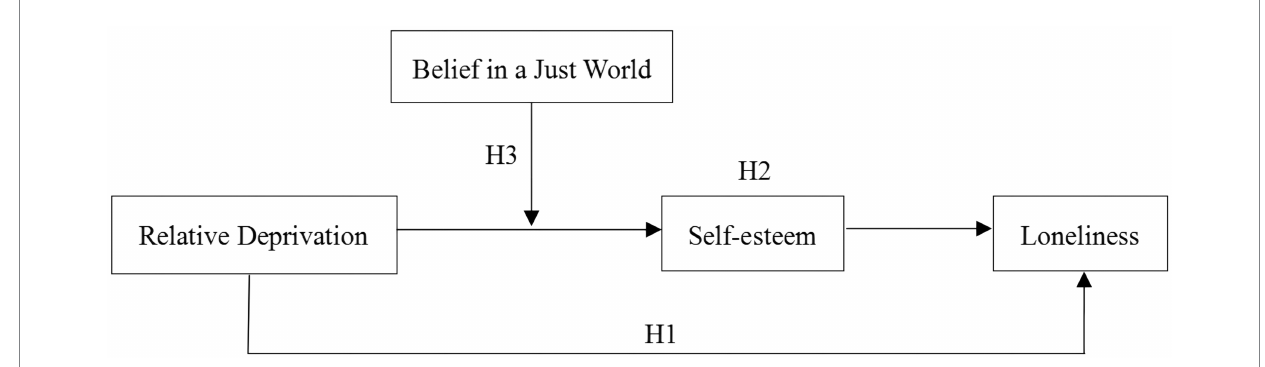
FIGURE 1 Moderated mediation model of the present